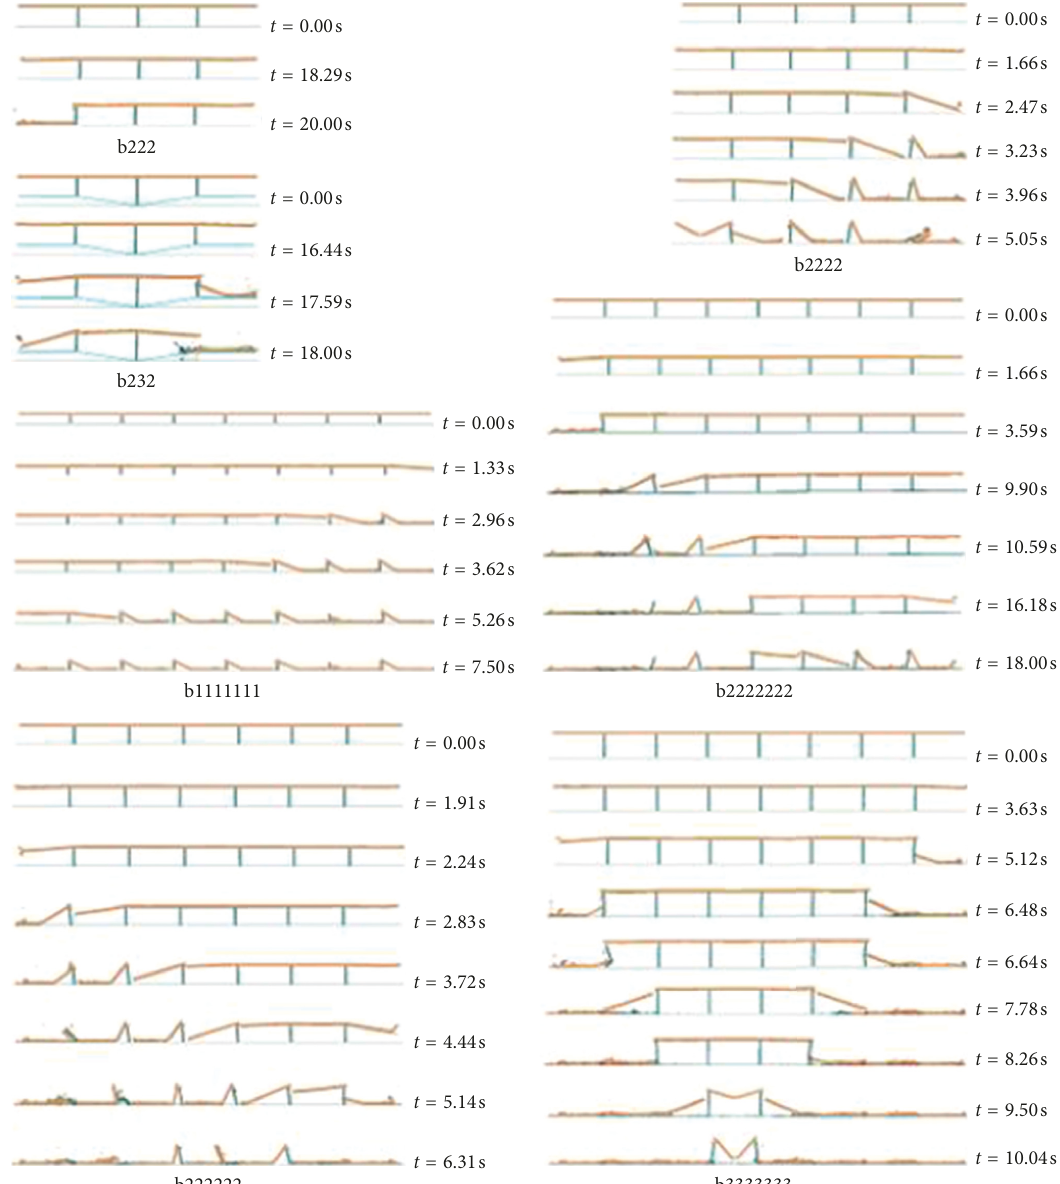
Figure 16: Collapse process of regular bridges under the artificial